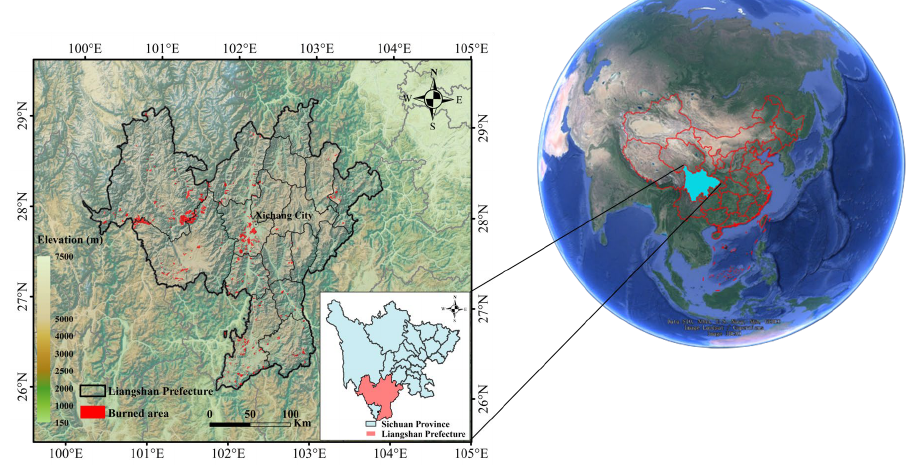
Figure 1. Overview of the study area.